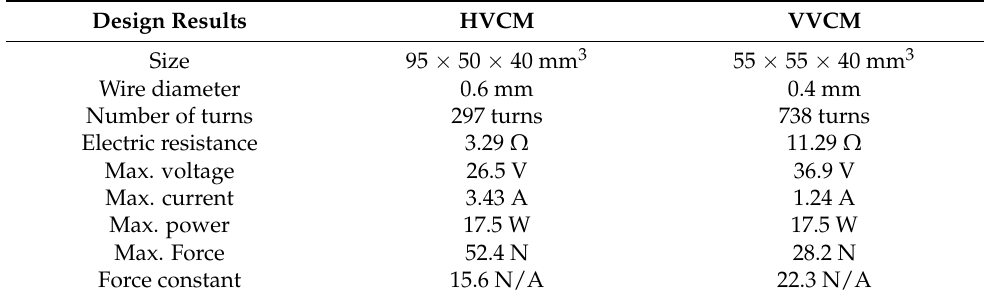
Table 1. Design specifications of the VCMs of the fine stage [27]. Reprinted from International Journal of Applied Electromagnetics and Mechanics, 62, Dahoon Ahn, et al., Design process of square column-shaped voice coil motor design for magnetic levitation stage, 517–540, Copyright (2020), with permission from IOS